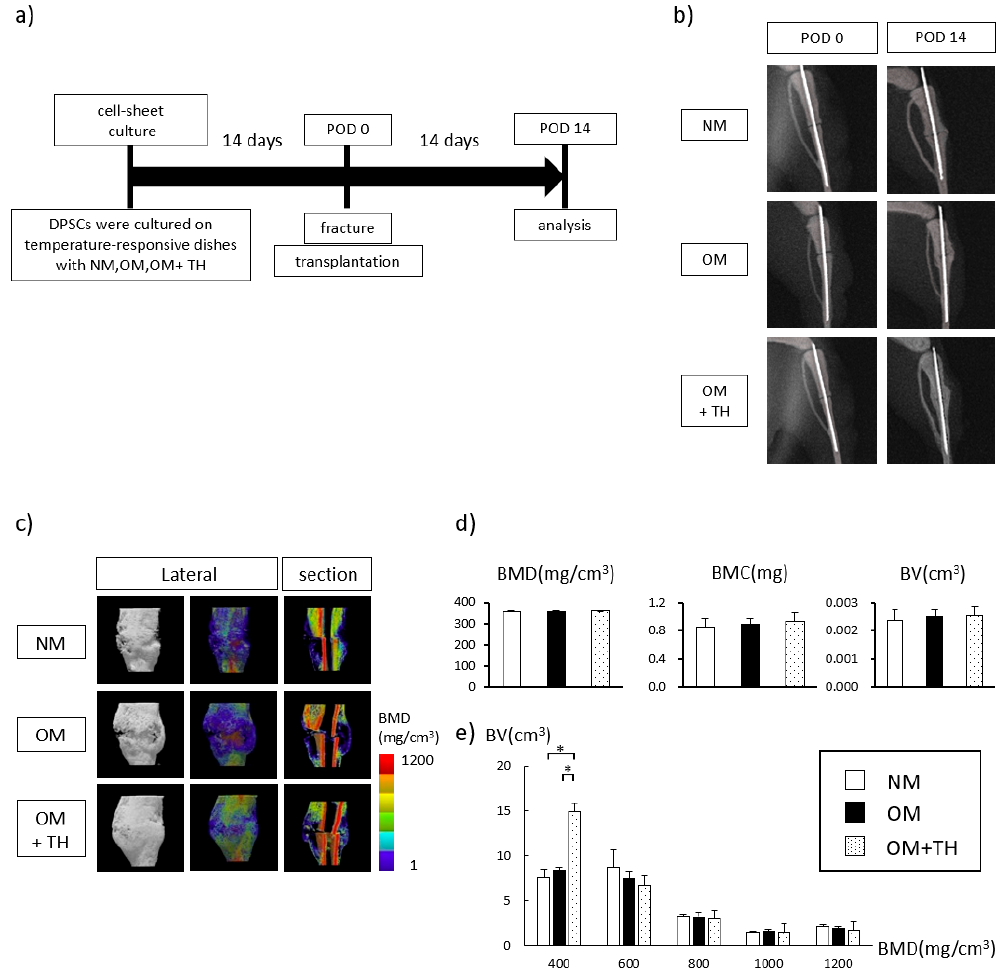
Figure 2. Radiological findings of callus formation induced by the transplantation of DPSCs into mice 14 days after surgery; ( a ) this is experimental procedure. DPSCs sheets were cultured in NM, OM, or OM + TH. Mice underwent the tibia fracture operation. DPSCs sheets were transplanted in tibiae fracture sites. On POD 14, the fractured tibiae were harvested. ( b ) X-ray images of the fracture sites of mice at POD0 and PO14. ( c ) representative three-dimensional (3D) micro-CT images of fractured tibiae transplanted with DPSCs cultured in NM or OM with or without TH ( n = 9). Lateral views and sagittal images are shown. Color-mapped images were created from bone mineral density (BMD) values. ( d ) quantification of BMD, bone mineral content (BMC), and bone volume (BV) of a 5 by 5 by 4-mm cuboid from the callus in which the fracture line was adjusted to be at the center. ( e ) BMD was calculated in every 200 mg / cm 3 region and the BV values of each BMD region are shown. Data are shown as means ± SEM of seven mice in each group. * p < 0.05 by one-way ANOVA. We performed histological analyses to investigate bone regeneration in endochondral ossification. Hematoxylin and eosin (H&E) and alcian blue double staining showed that the area of alcian blue-positive cartilaginous tissue was larger for OM + TH-treated DPSCs compared with the